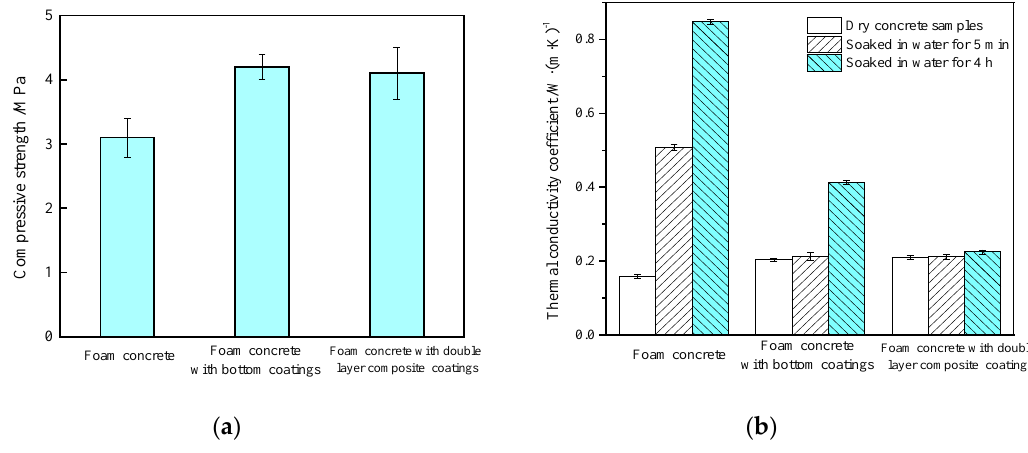
Figure 14. Compressive strengths ( a ) and heat-preserving properties ( b ) of different foam concrete test blocks.